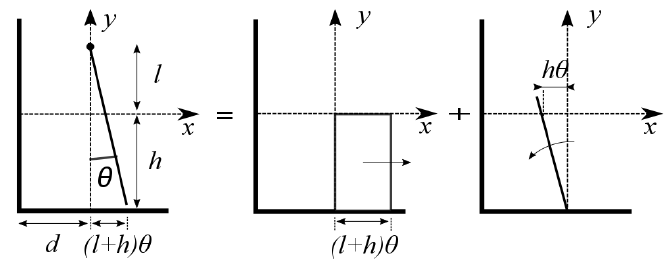
Figure A1. Graphical interpretation of superposition of piston type wave maker and bottom hinged flap wave